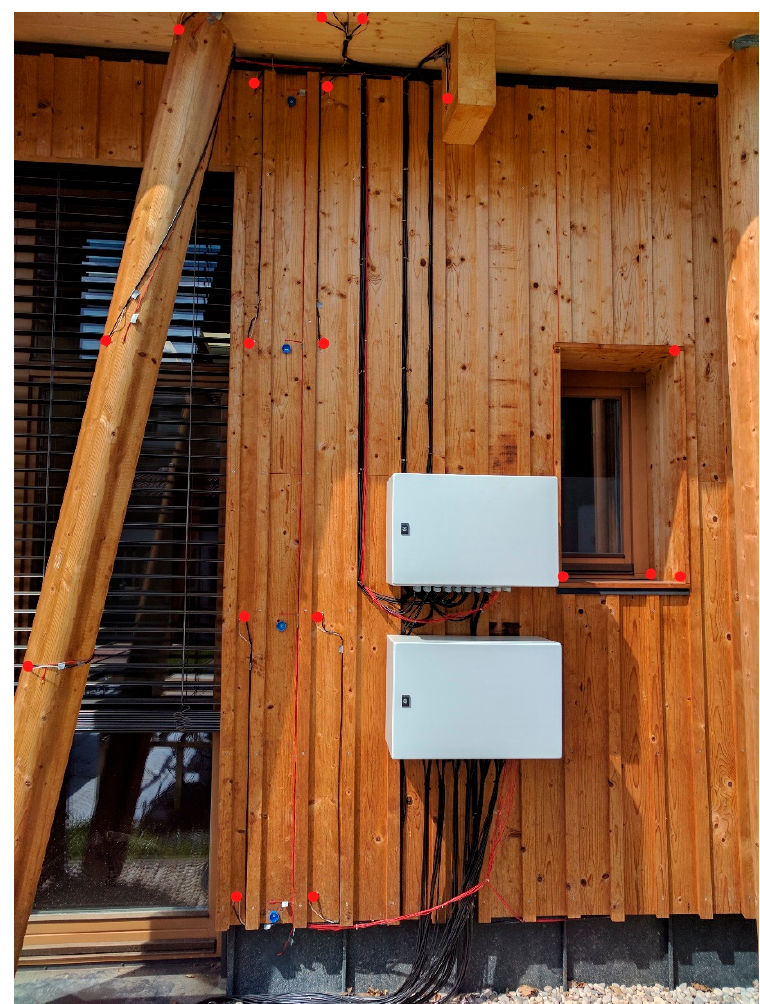
Figure 2. Position of wood moisture and temperature sensors on the façade of the Annex. The red dots indicate locations of the measurements.